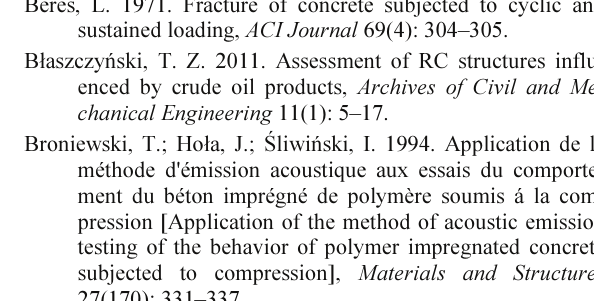
Fig. 16. Fatigue strength of concretes A/S A , B/S A , C/S V and D/S V versus stress cycles for ρ f = 0 and f = 1